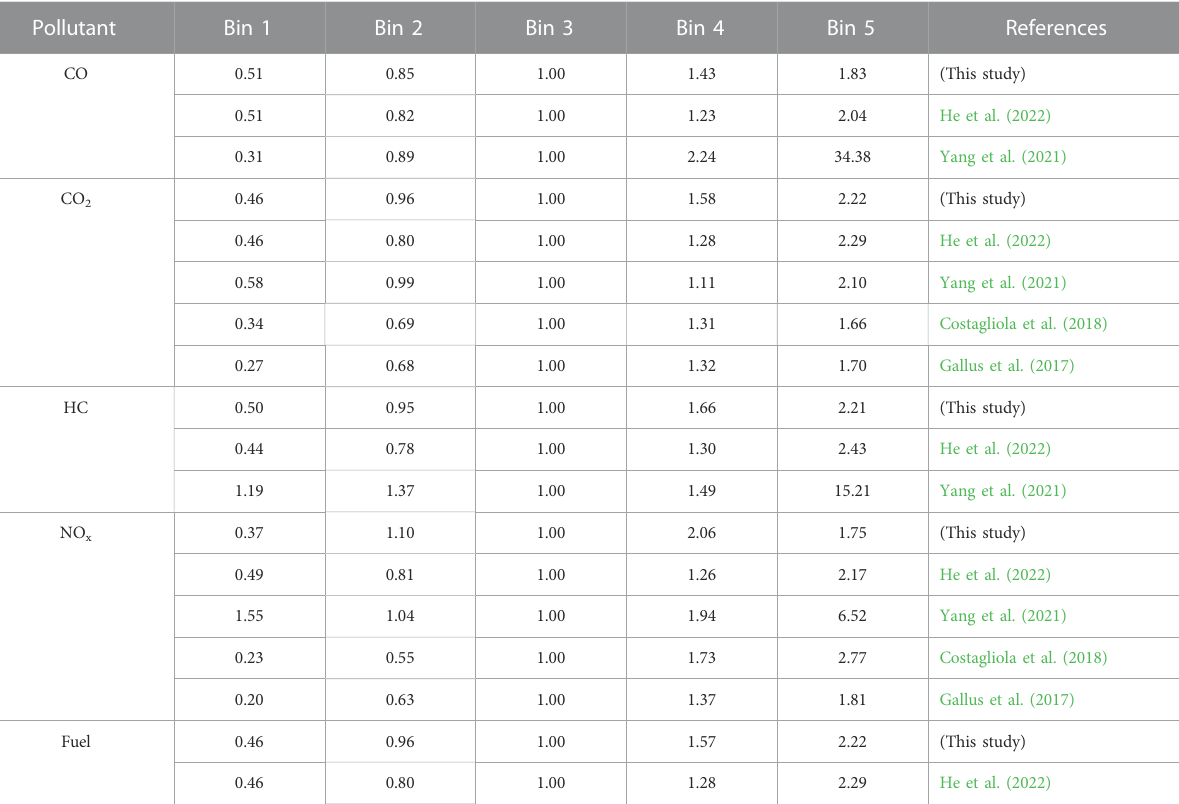
TABLE 4 Comparison of pollutant average emission rate ratios in different research using fl at road (Bin 3 in this study) emission rates as a baseline.